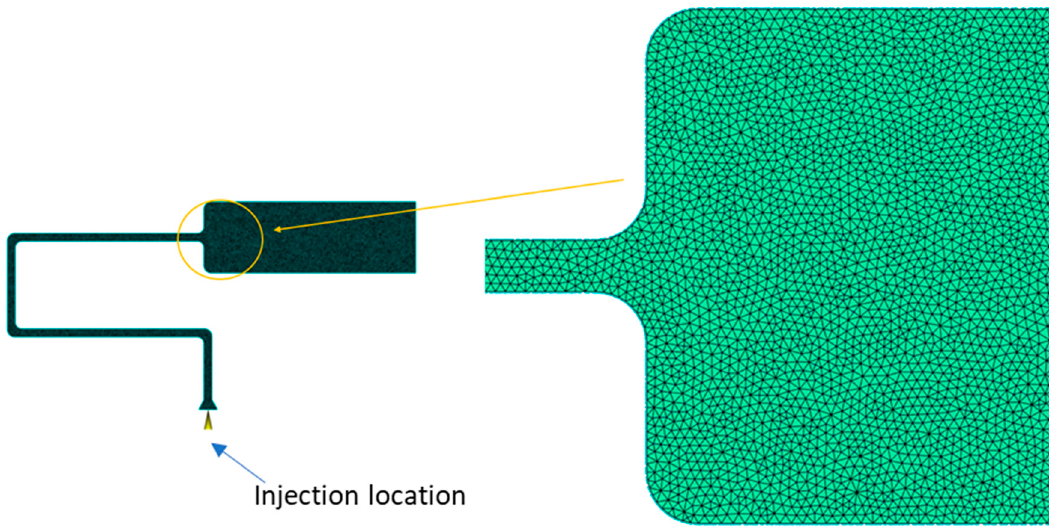
Figure 2. Element size 0.1mm 3D (Fine mesh).